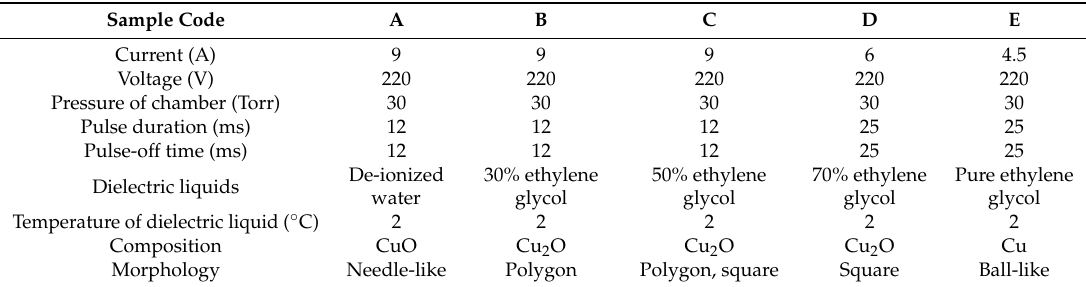
Table 1. Effect of process parameters on the composition and morphology of particles obtained by the submerged-arc nanoparticle synthesis system (SANSS)